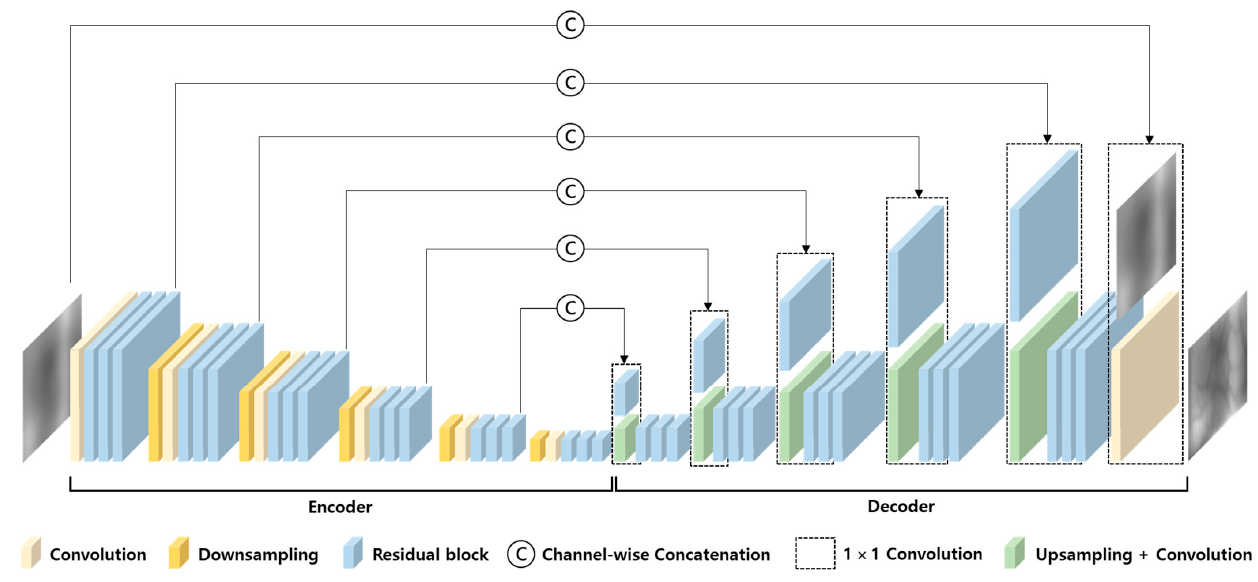
Figure 3. Architecture of the proposed RMOBF-Net. Table 2. Description of the proposed RMOBF-Net (× 3 means the number of iterations ).